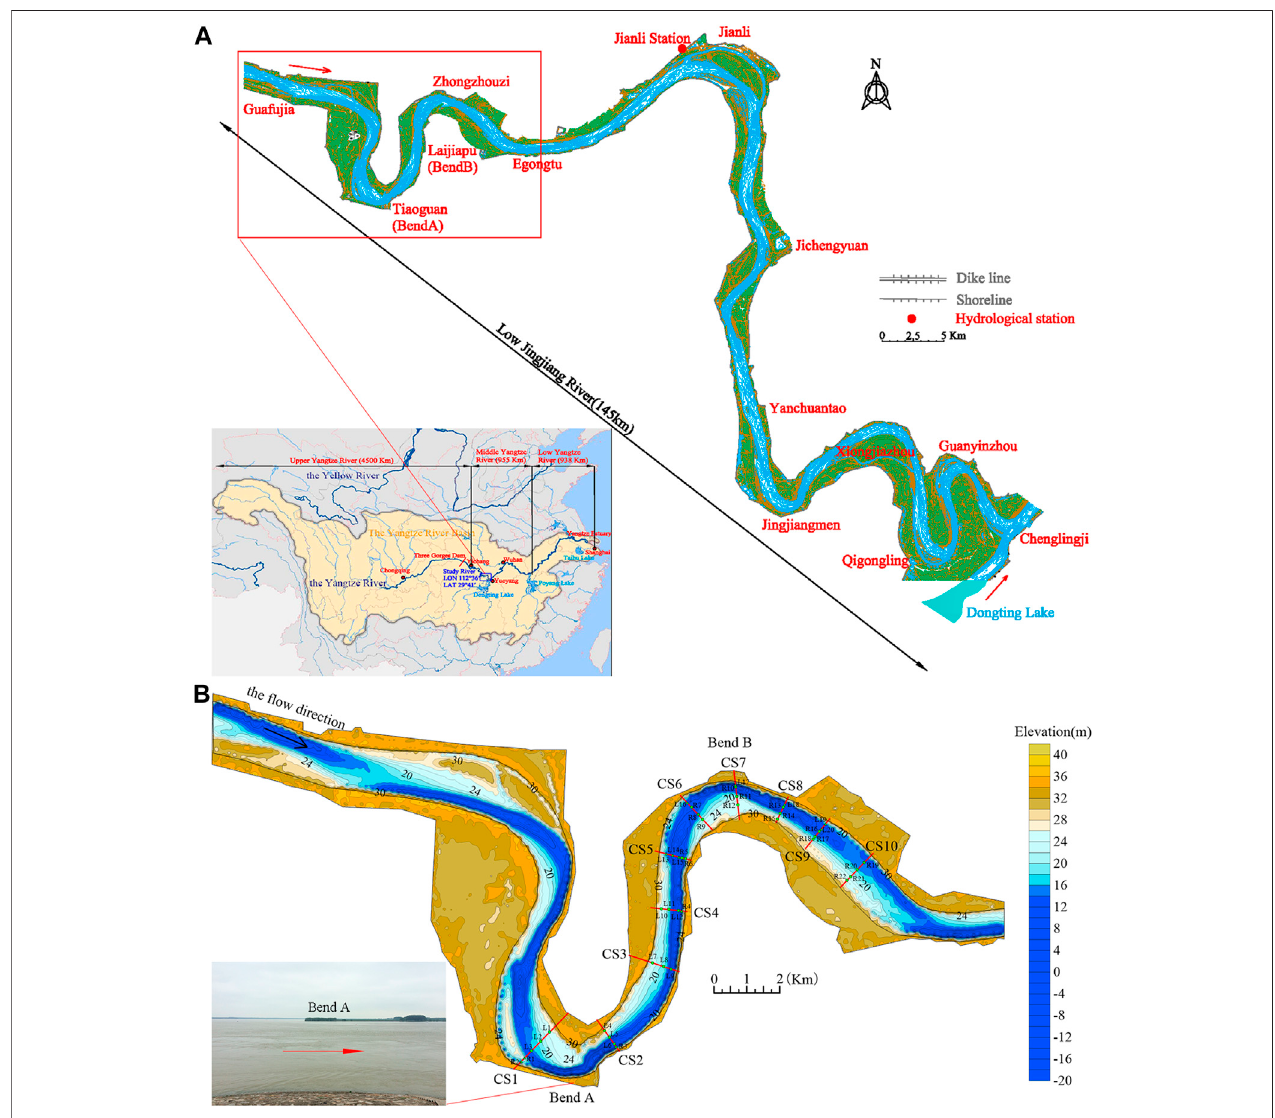
FIGURE 1 | (A) The LJR and the Yangtze River Basin, including the location of hydrological station and the study area. (B) Sketch maps of the study area from Tiaoguan reach (Bend A) to Laijiapu reach (Bend B), including cross sections CS1-CS10, where measurements were taken.